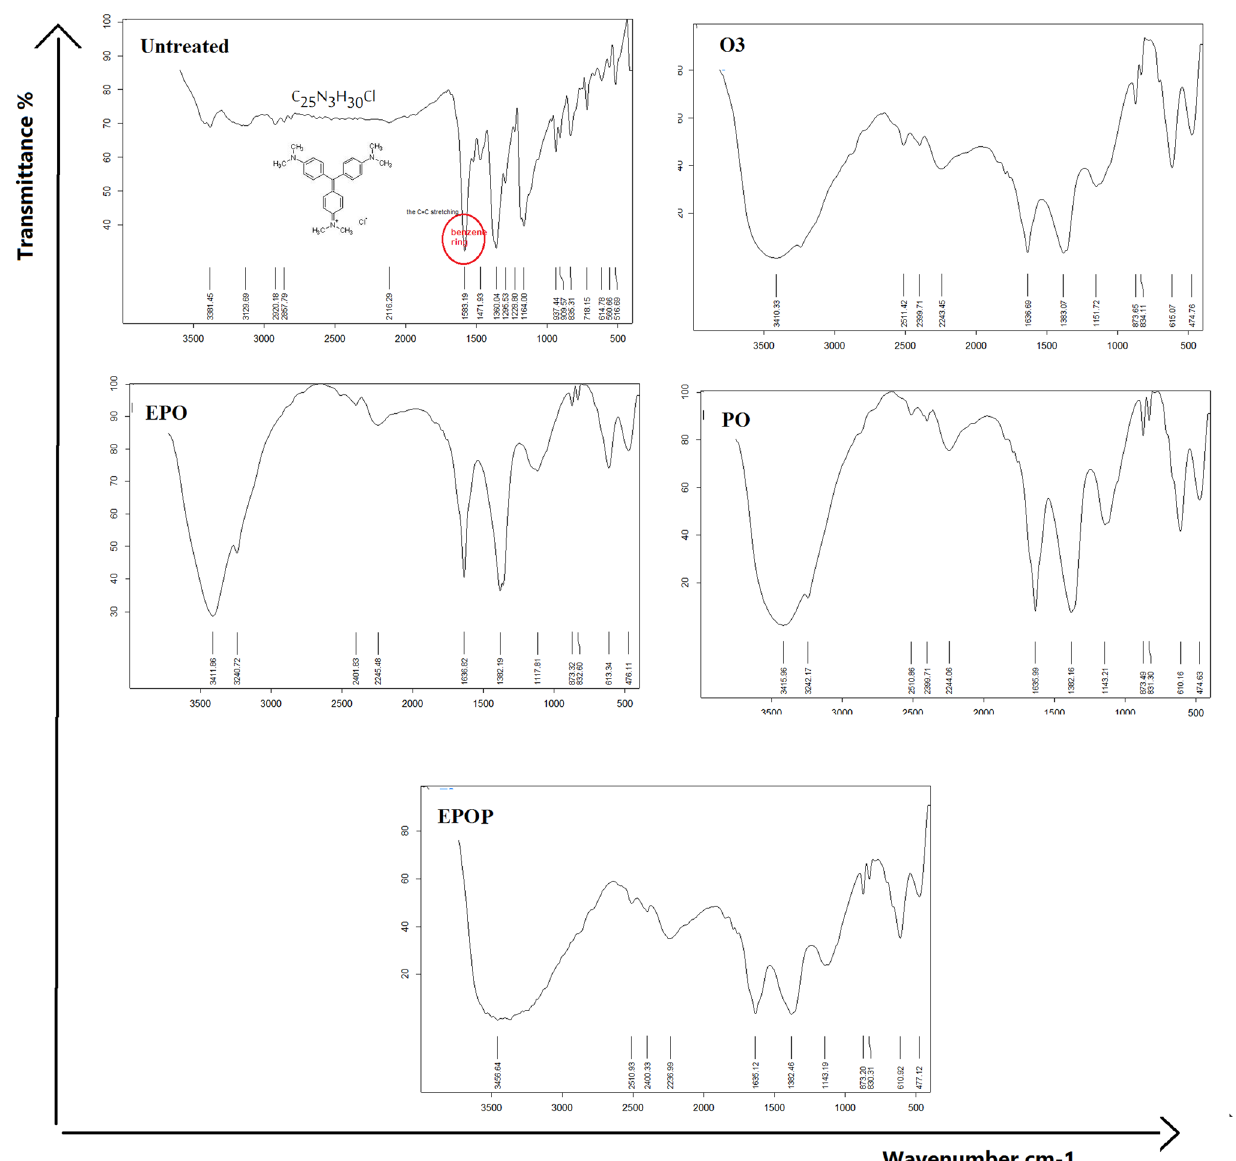
Fig. 6 FTIR analysis of treated wastewater with different oxidation